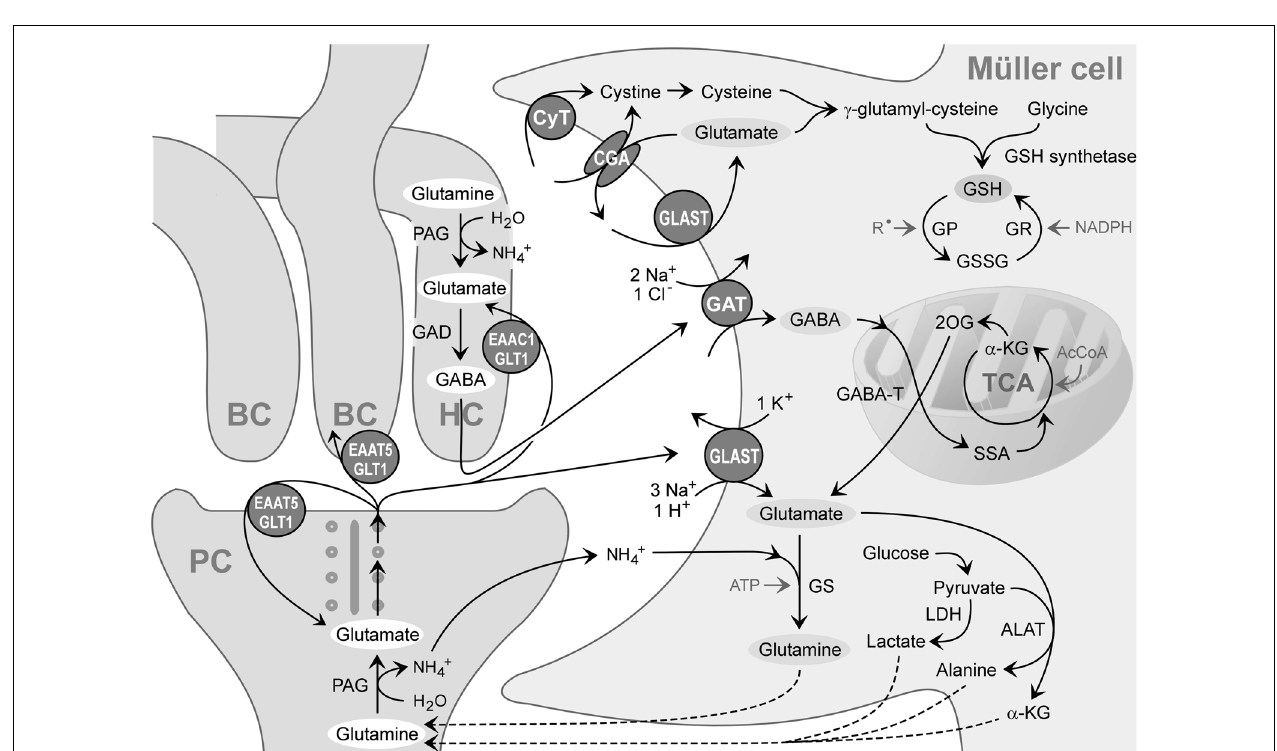
enzyme GABA transaminase (GABA-T) catalyzes the formation of glutamate from 2-oxoglutarate (2OG), coupled to a conversion of GABA to succinate semialdehyde (SSA). Another metabolic way is the production of reduced glutathione (GSH) which is an intracellular antioxidant, released from Müller cells and taken up by neurons under oxidative stress conditions. AcCoA, acetyl coenzyme A; ALAT, alanine aminotransferase; CGA, cystine-glutamate antiporter; CyT, cystine transporter; EAAC1, excitatory amino acid carrier 1; ) EAAT5, excitatory amino acid transporter 5; GAD, glutamic 4